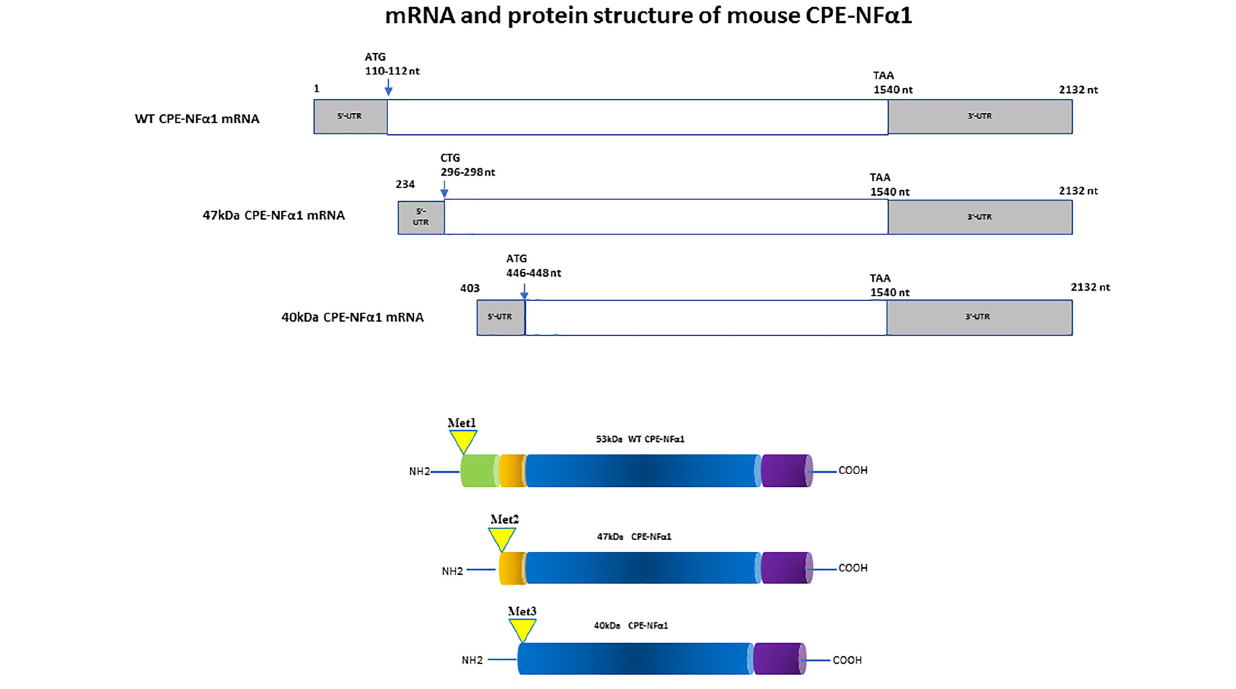
FIGURE 1 | mRNA and protein structure of mouse CPE-NF α 1. There are three CPE-NF α 1 transcripts: a 2.3 kb CPE-NF α 1 mRNA WT transcript and two variants, 1.9 and 1.73 kb transcripts generated by alternative transcription start sites in mouse embryonic brain. CPE-NF α 1 mRNA WT transcript produces a 53 kD protein, while the two mouse CPE-NF α 1 mRNA variants produce two N-terminal truncated CPE-NF α 1 proteins with 47 and 40 kD, respectively. Numbers in the 47 and 40 kD CPE mRNA refer to their relative position in the wt-CPE mRNA.